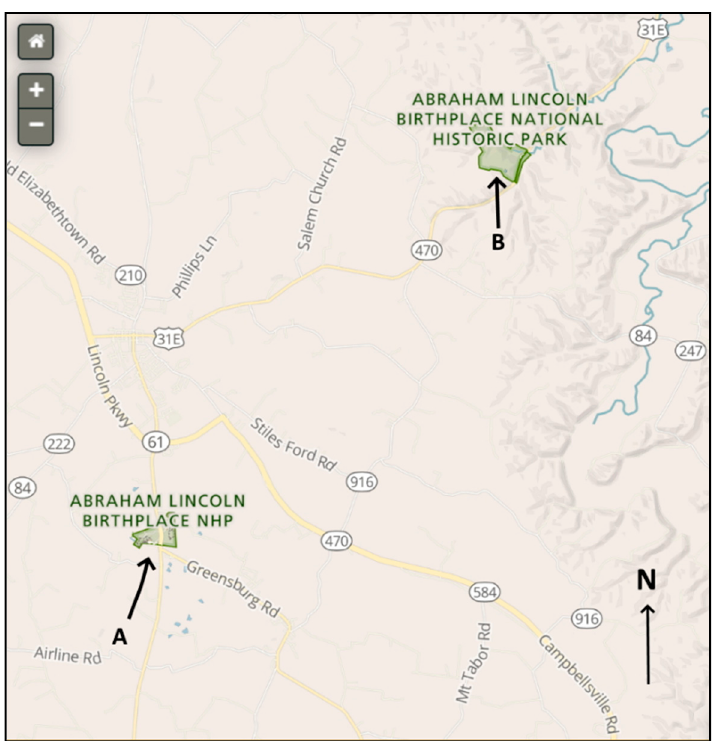
Figure 2. Location of the two sampling locations in Abraham Lincoln Birthplace National Historical Park in Kentucky, USA.